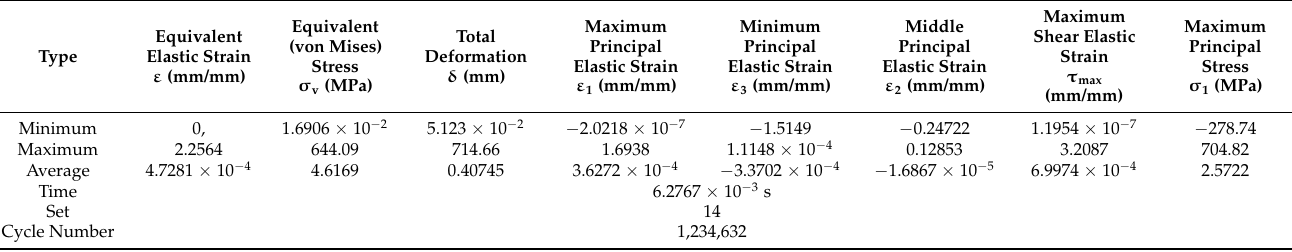
Table 10. ANSYS dynamic simulation